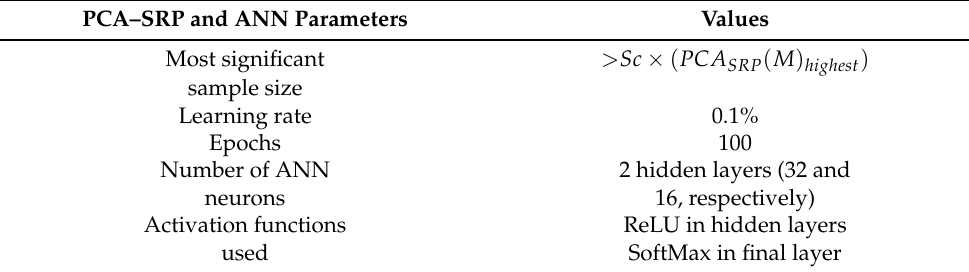
Table 3. PCA–SRP and ANN parameters.